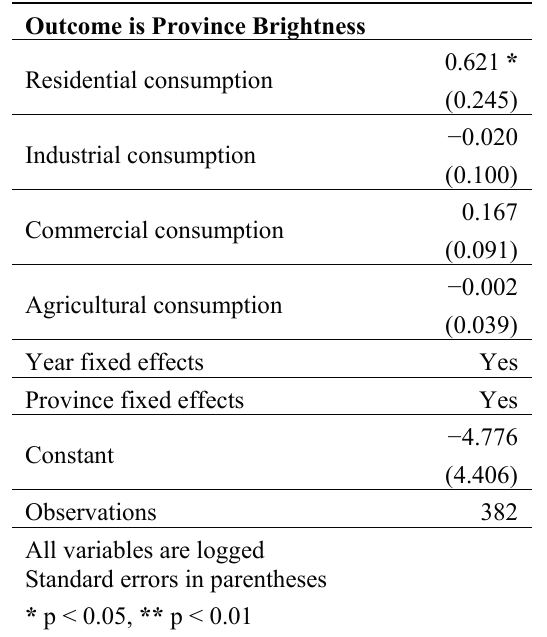
Table 1. Sectoral determinants of province